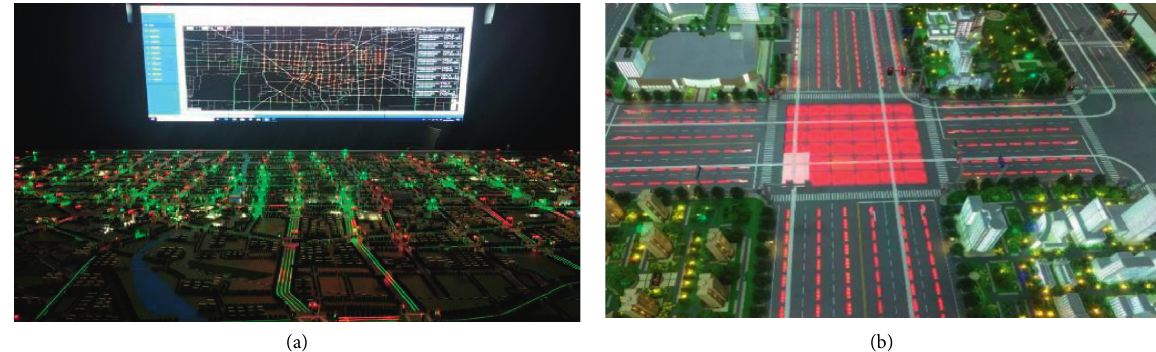
Figure 8: Visualized hardware and software in the loop system of Weifang City in Shandong Province, China. (a) Visualized hardware and software in the loop system. (b) Cellular